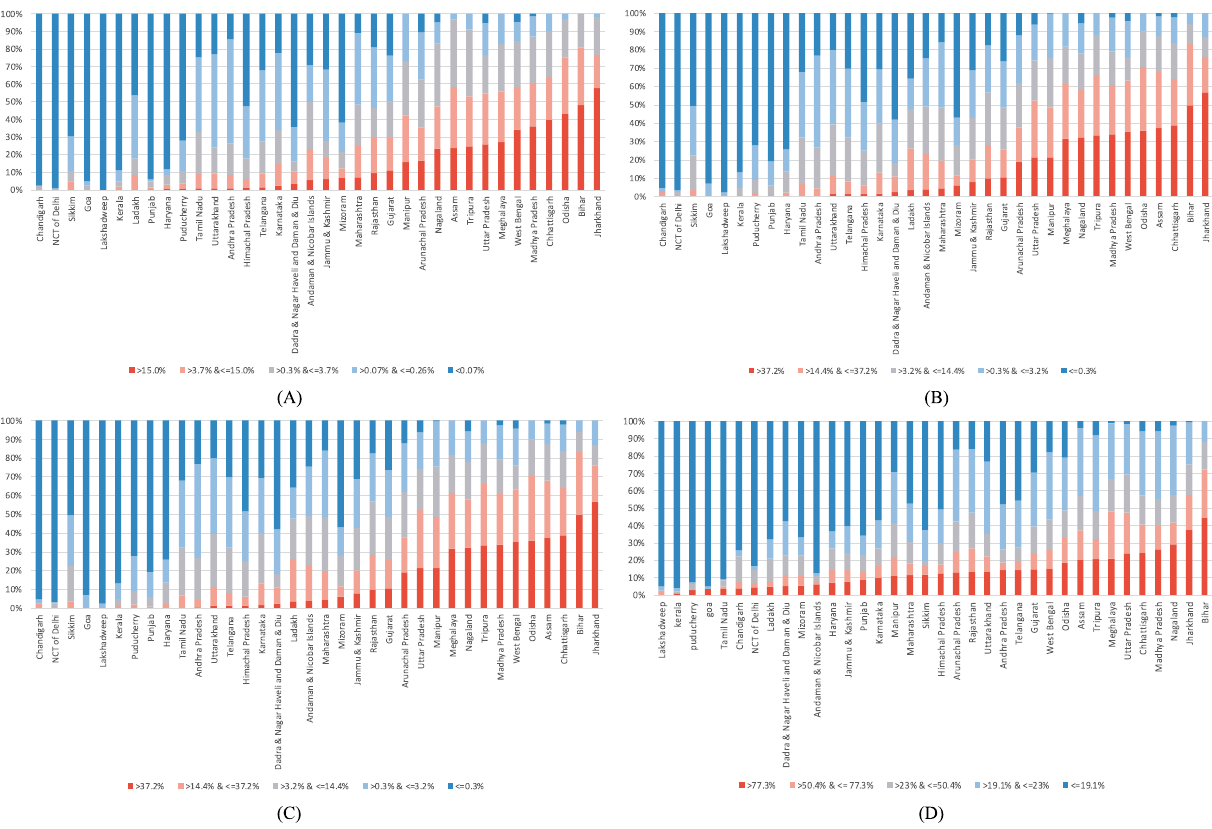
Fig. 9 Cluster-level percent prevalence of each measure of poverty by state and Union Territory in 2021. A Bottom 10th wealth percentile. B Bottom 20th wealth percentile. C Below poverty line (BPL). D Multidimensionally poor